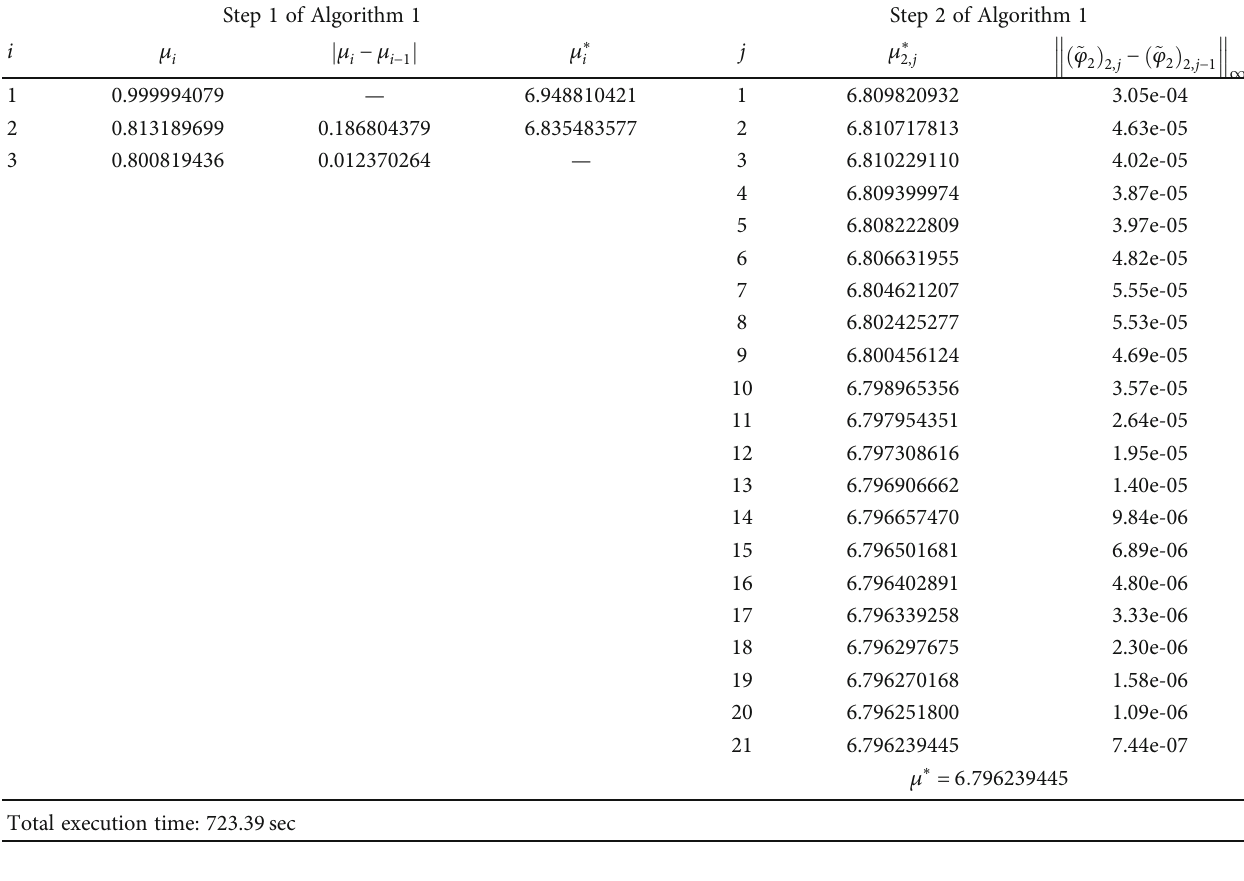
Table 1: The fi rst bifurcation points and associated energy levels of (15) with V β = 500 , λ = 200 , and ω = 0 : 9 .